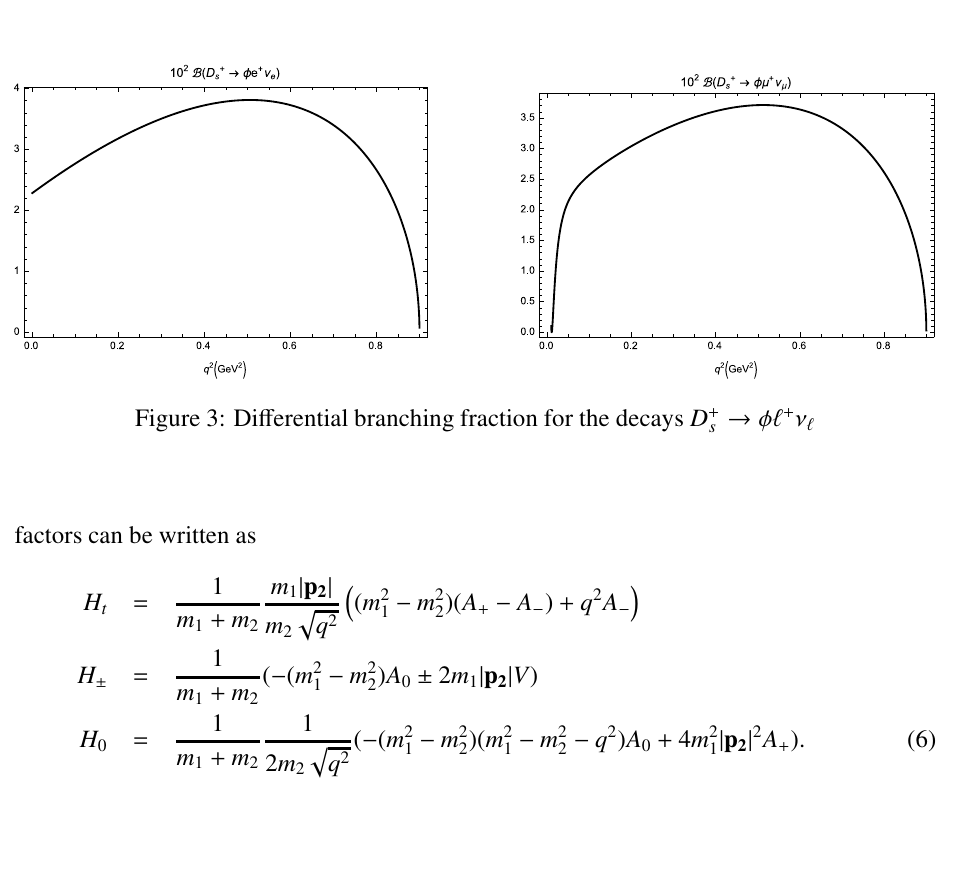
Figure 2: Form factors for q 2 ≥ 0